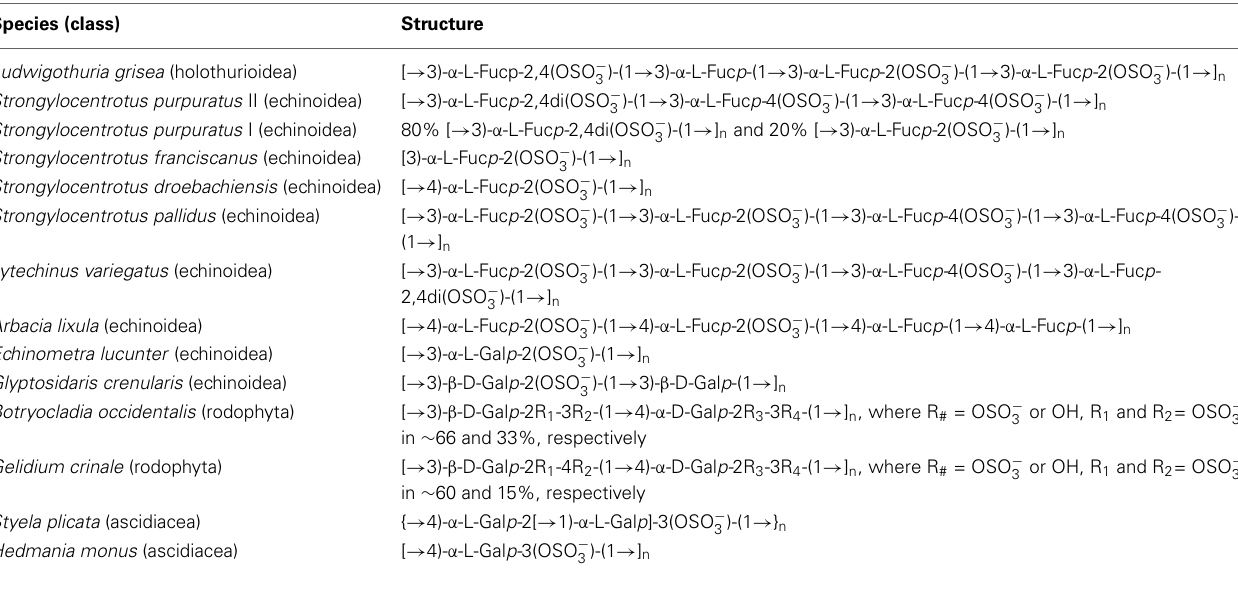
Table 2 | Oligosaccharide repetitive units of SFs and SGs from echinoderms sea-urchins (Echinoidea), and sea-cucumber (Holothuroidea), red algae (Rhodophyta), and ascidians or tunicates